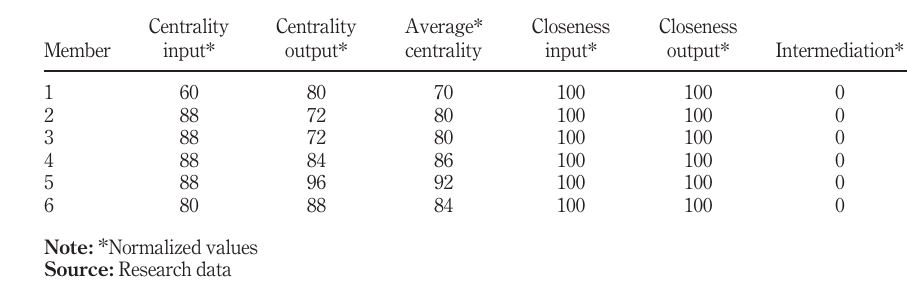
centrality of the incubator